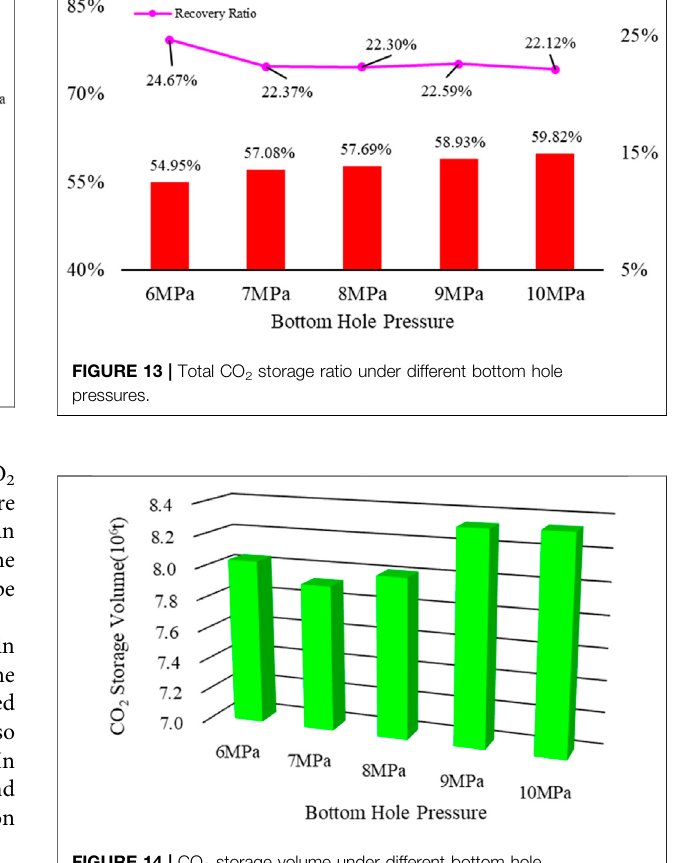
FIGURE 14 | CO 2 storage volume under different bottom hole